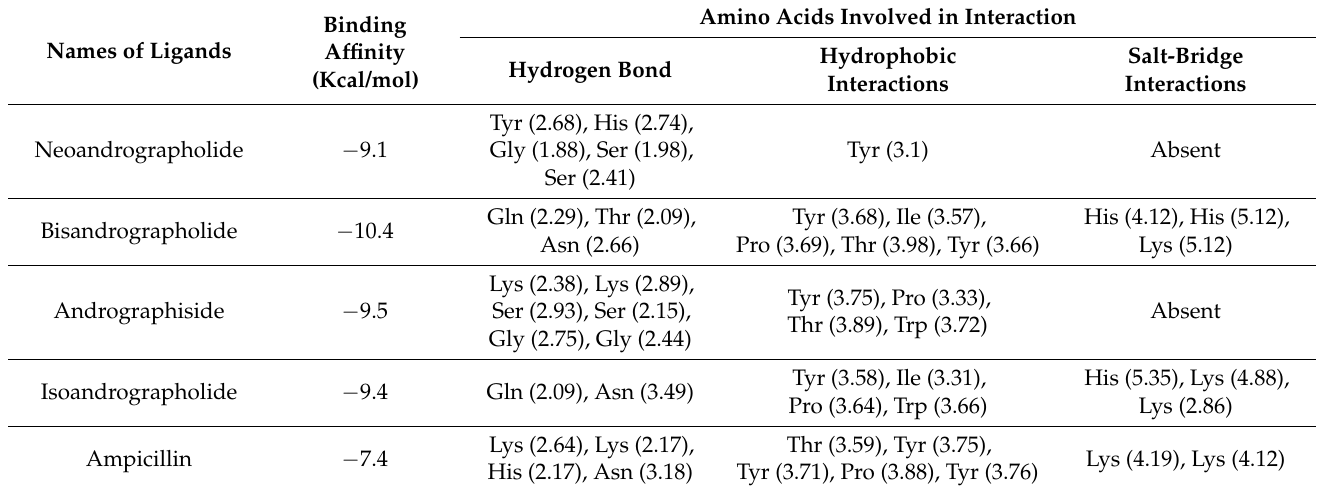
Table 2. Molecular interactions of best